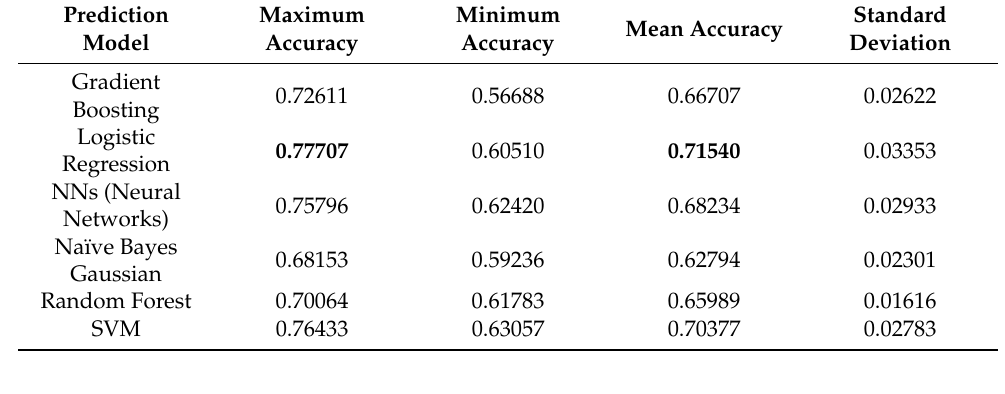
Table 6. Maximum, minimum, and mean accuracy of prediction models over the tested set for the left leg. The best results are indicated with bold.